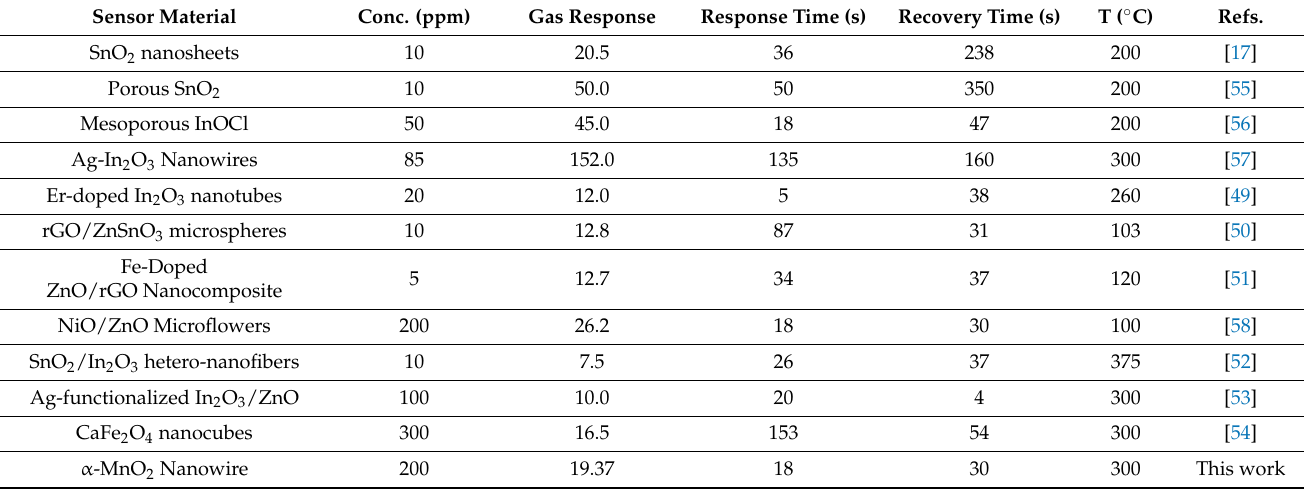
Figure 5. ( a ) Gas response vs. operating temperature for 200 ppm HCHO gas, ( b ) variations of gas response as a function of concentration of HCHO gas, ( c ) dynamic repeatable response–recovery curves for 200 ppm HCHO gas at optimized 300 ◦ C temperature (Inset: response–recovery curve for the calculation of response and recovery times), and ( d ) sensor stability test for 7 days using α -MnO 2 nanowire-based gas sensor toward 200 ppm HCHO gas at 300 ◦ C. Table 1. Sensing parameters for various gas sensor materials toward